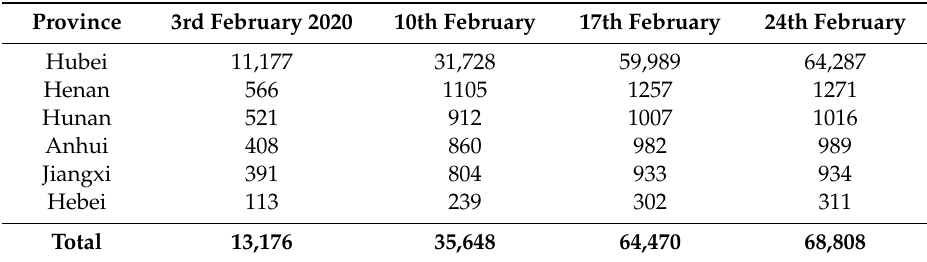
Table 2. Number of reported cases, China ( < 700 km from Wuhan).